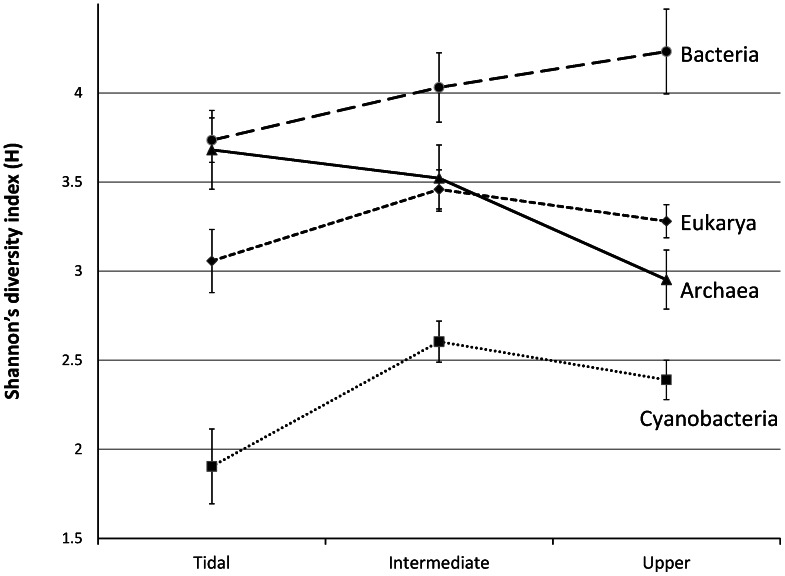
Shannon diversity index (h) of the four different microbial communities averaged per zone.